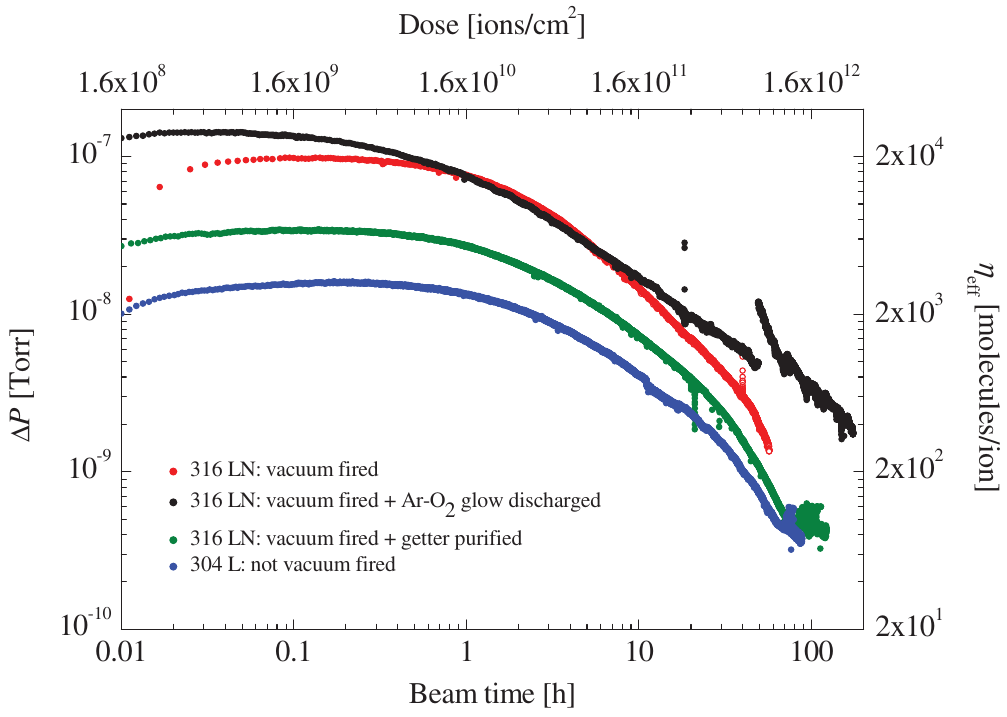
FIG. 7. (Color) Beam cleaning measurements for four different stainless steel (316LN, 304L) vacuum chambers continuously bombarded with 1 : 5 (cid:2) 10 9 Pb 53 ions (per shot) under (cid:2) ¼ 89 : 2 (cid:5) grazing incidence. The shown desorption measurements were done with 4 : 2 MeV = u lead ions at LINAC 3; all four vacuum chambers were cut afterwards and samples of each chamber were studied with ERDA [70]. The obtained ERDA results are displayed in Fig.